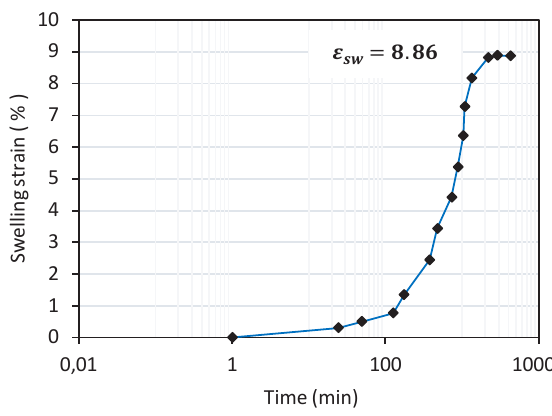
Figure 2: Free swelling strain versus elapsed time.